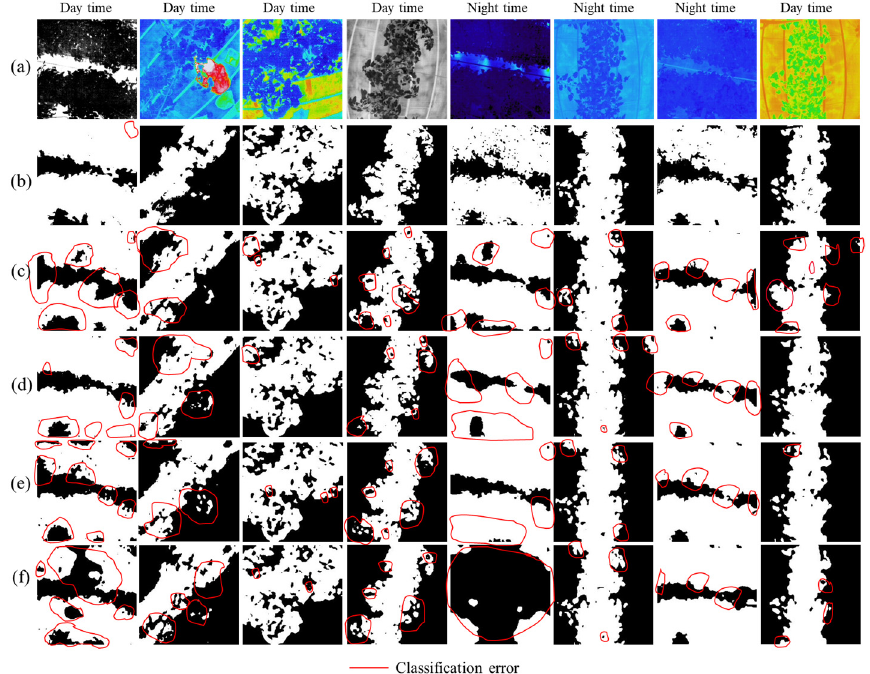
Figure 10. Visualization of the challenges for semantic segmentation of crops (thermal RGB) grown in plant factory: ( a ) thermal color and monochrome RGB image of tomato; ( b ) ThelR547v1 predicted ground truth image; ( c ) Deeplabv3plusInceptionresnetv2 predicted ground truth image; ( d ) Deeplabv3plusXceptionNet predicted ground truth image; ( e ) Deeplabv3plusResNet50 predicted ground truth image; ( f ) Deeplabv3plusMobilenetv2 predicted ground truth image.